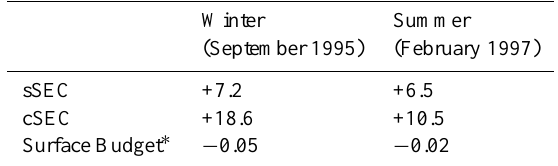
Table 1. Horizontal transport up to 200 m of main salinity sources along the easternmost boundary of the REVIZEE observed area and the surface budget at this area (Sv).